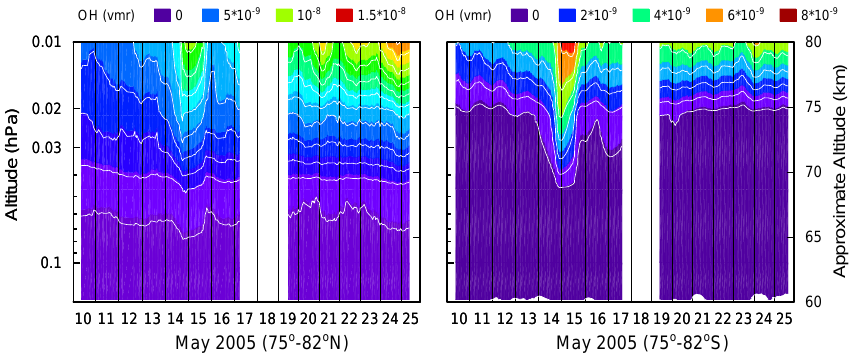
Fig. 4. Temporal evolution of averaged values ( ∼ 75 ◦ –82 ◦ N and S) of May 2005 OH volume mixing ratio (vmr), approximately in meso- sphere, in the Northern Hemisphere (left) and Southern one (right) (see the caption of Fig. 2 for the correspondent